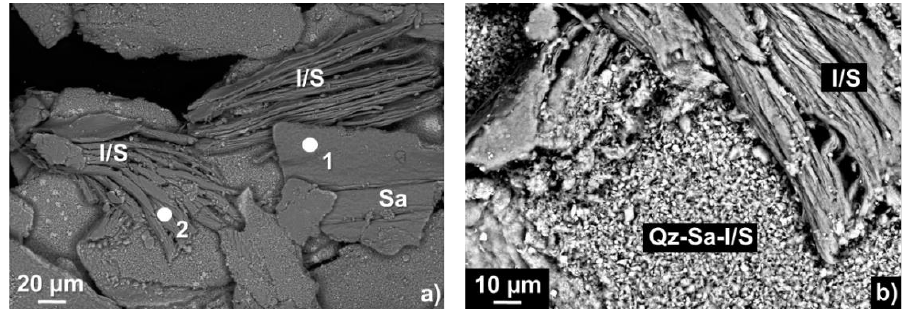
Figure 6. ( a ) Backscattered electron image of the clay fraction of sample 04MRE123 with sanidine (Sa) and elongated illite/smectite (I/S) flakes. The white dots (1 and 2) indicate spots where energy dispersive X-ray spectroscopy spectra were collected. ( b ) Backscattered electron image showing fine aggregates of sanidine, quartz and I/S (center of the image) as well as large I/S flakes.